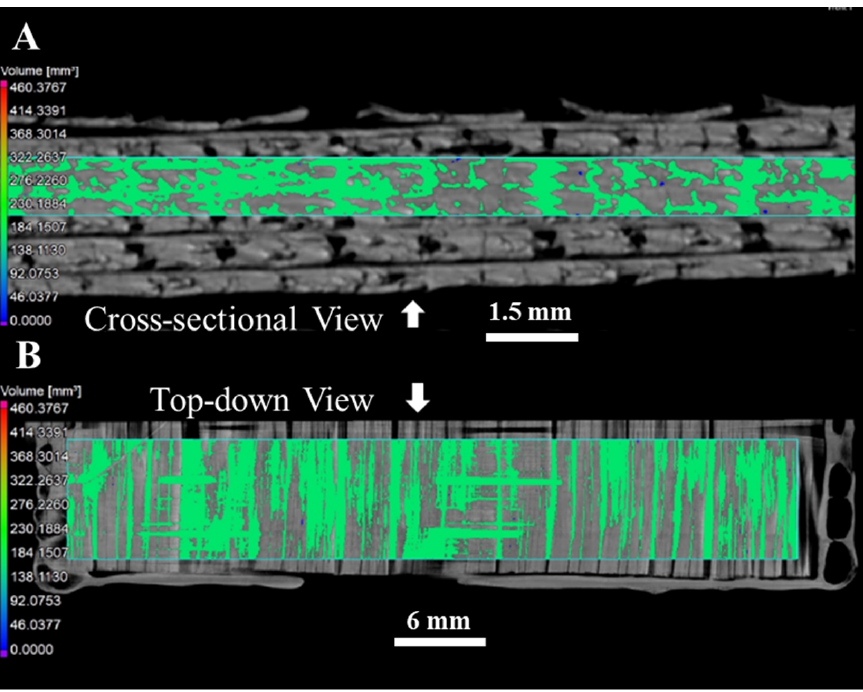
Figure 4. XCT scans of ( A ) cross ‐ section and ( B ) top ‐ down view of pyrolyzed Cf ‐ PEEK sample showing the porosity of the pyrolyzed Cf ‐ C composite. Table 1. Information on preforms, pyrolyzed samples, and MI samples.